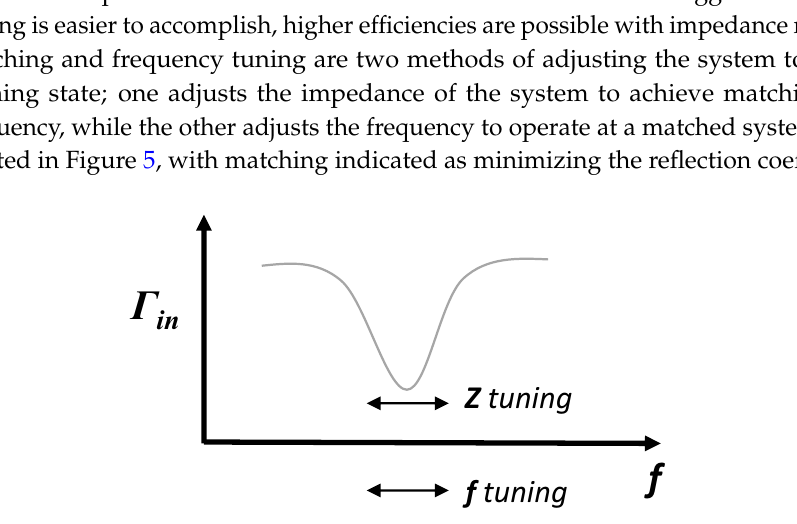
Figure 5. Illustrated relationship between impedance ( Z ) matching and frequency ( f )